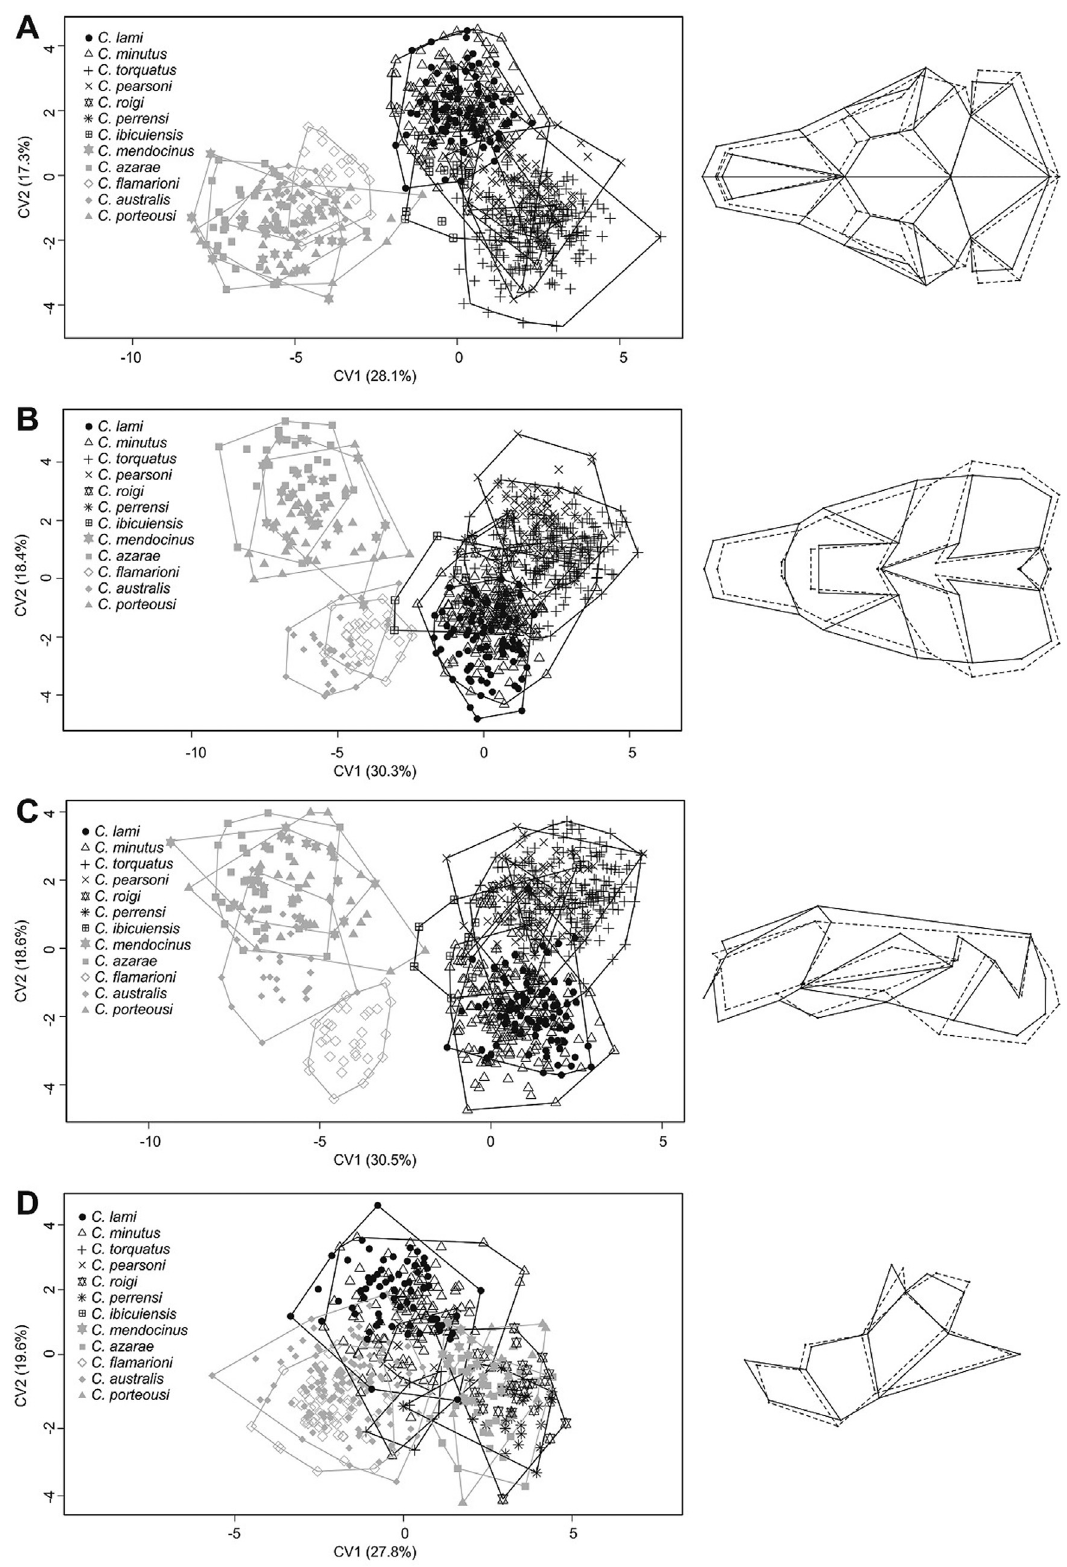
Figure 5 - Scatterplot of canonical variate analysis (CVA) show the two first canonical axis for 12 species of Ctenomys from the mendocinus and torquatus groups for dorsal (A), ventral (B), and lateral (C) views of the skull and lateral view of the mandible (D). The grids at the right side of each plot represent the differences for landmark configuration along the first CV, where dotted lines represent the extreme negative scores and solid lines represent the extreme positive scores. Variance percentages for CV1 and CV2 are given in